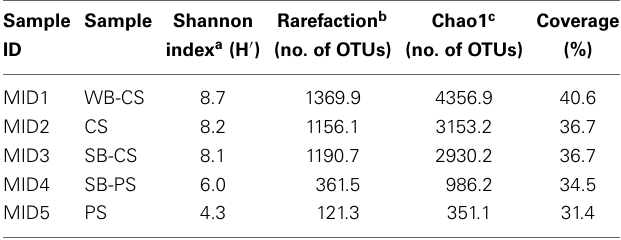
major phyla ( > 1% of total reads) was determined by 454 amplicon pyrosequencing of 16S rRNA extracted from all samples. Multi-colored charts at the legend are shown for each phylum and sample correspondingly. Phyla to which < 1% of reads were assigned were summarized as